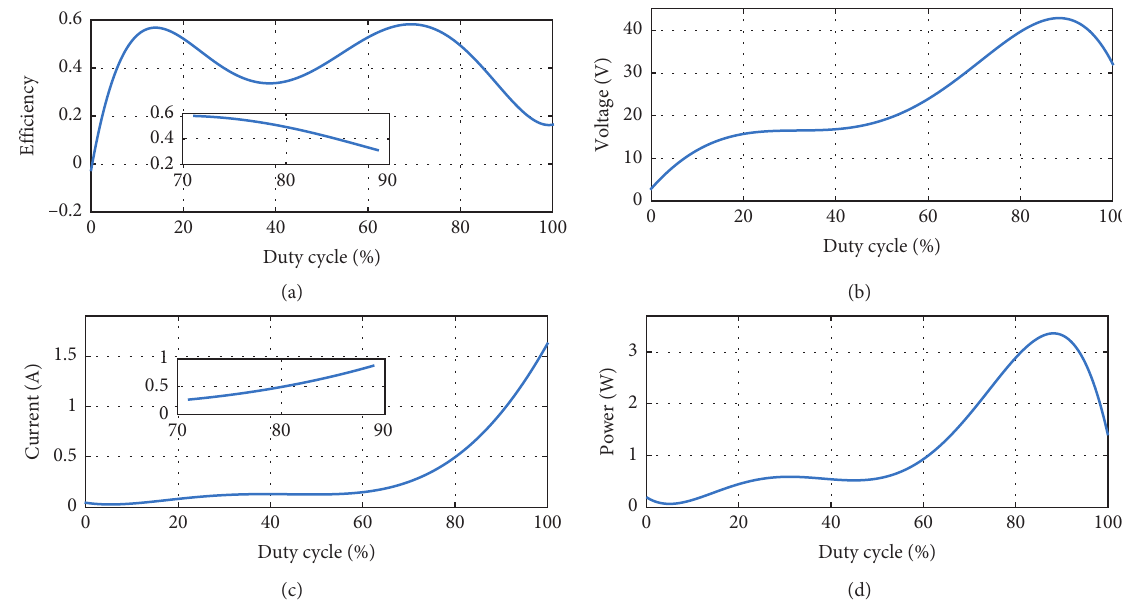
Figure 14: η − D , v − D , i − D , and P − D characteristic curves of the boost converter. (a) Efficiency vs duty cycle. (b) Output voltage vs o o duty cycle. (c) Inductor current vs duty cycle. (d) Output power vs duty cycle.